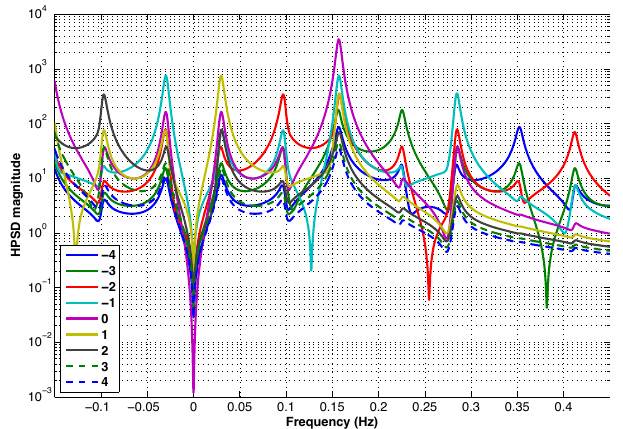
Figure 1. Harmonic power spectrum of the output of the Mathieu oscillator.